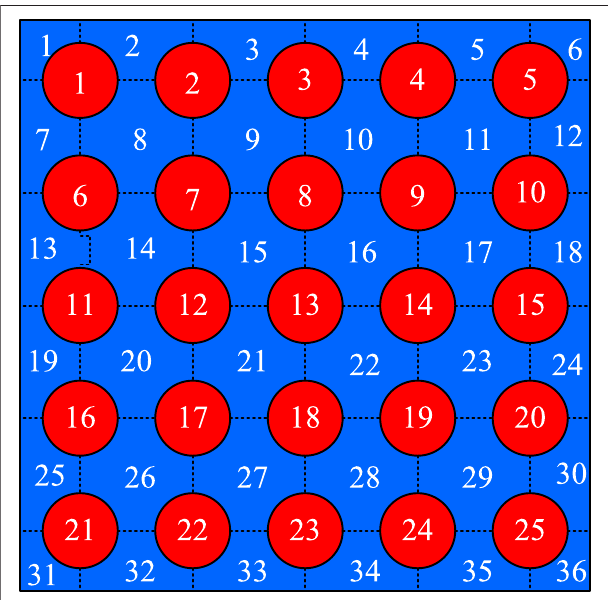
FIGURE 7 | Subchannel numbering in a 5 × 5 rod bundle.